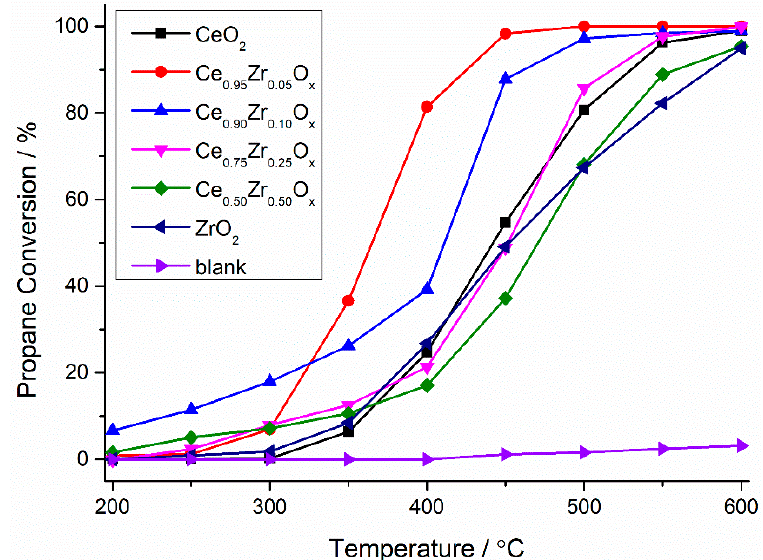
Figure 1. Catalytic activity for the total oxidation of propane over the ceria–zirconia mixed metal oxide catalysts prepared using carbonate precursors. Reaction conditions: GHSV = 45,000 h − 1 , 5000 ppm propane in air. Legend refers to Ce:Zr ratios.